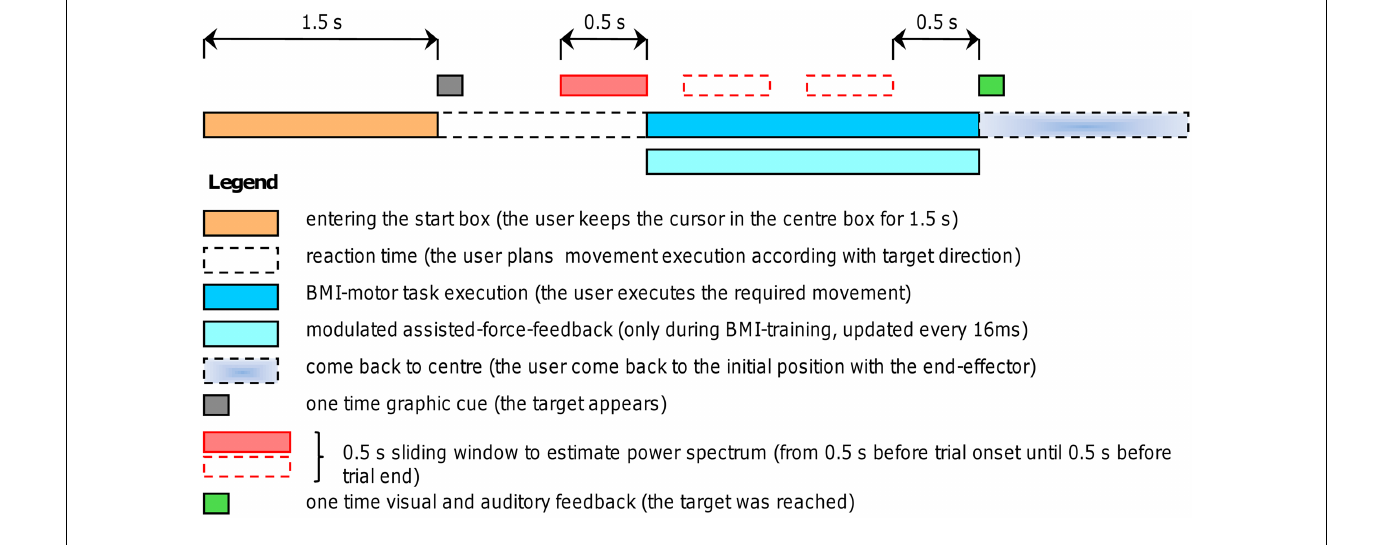
FIGURE 2 | Experimental procedure .Timing of self-paced trials with and without assisted-force-feedback (the force applied to the robotic arm was continuously updated every 16ms). A self-paced trials starts by entering the center box, after 1.5s a target appears (one out of four possible directions), thus the user plans the movement execution and initiates the movement